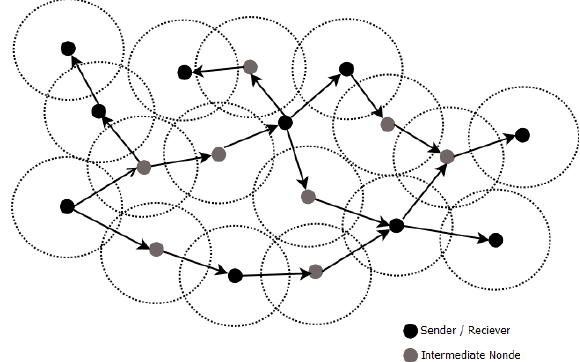
Fig. 2. Simulation topology for 10